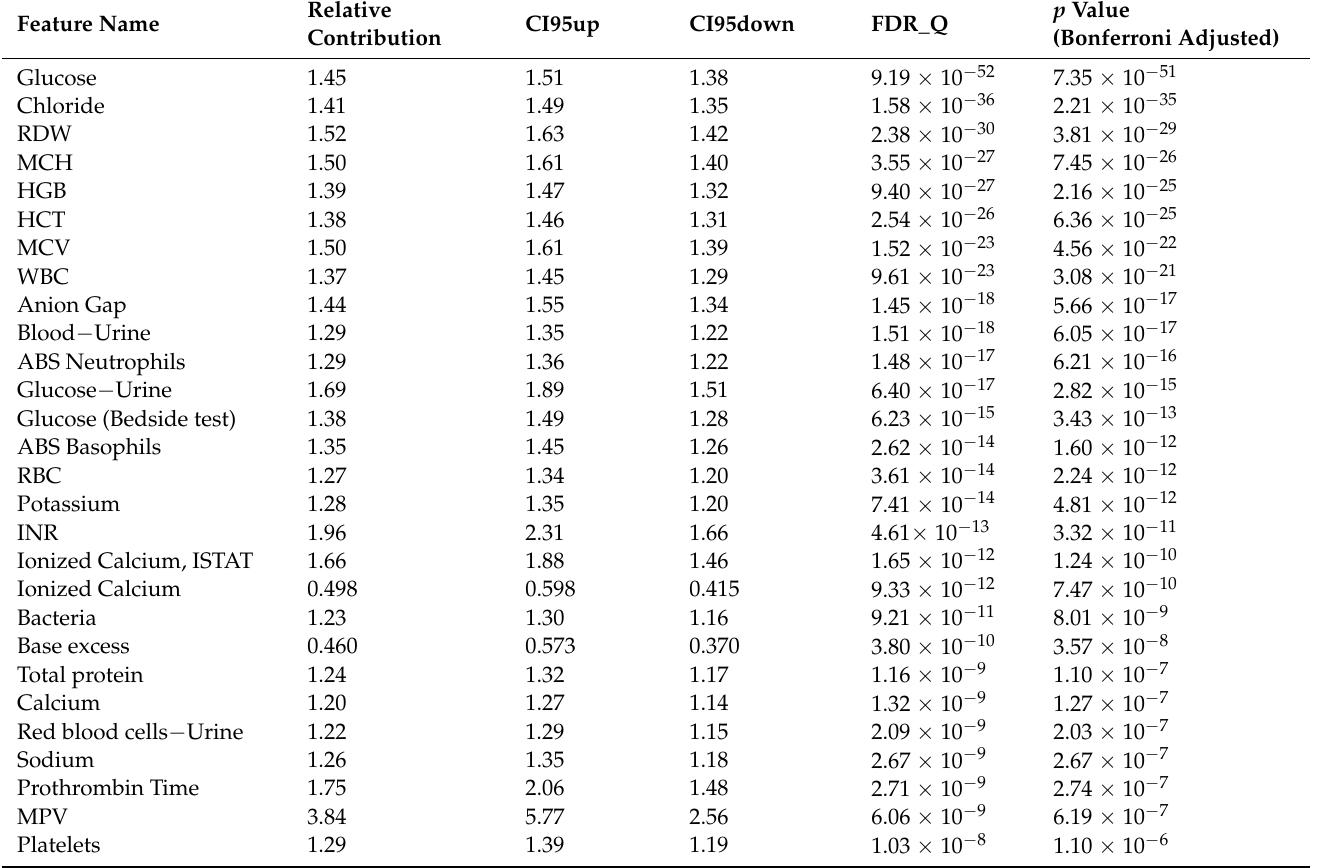
Table 2. Important lab test results identified by perturbation-based contribution analysis for SRE